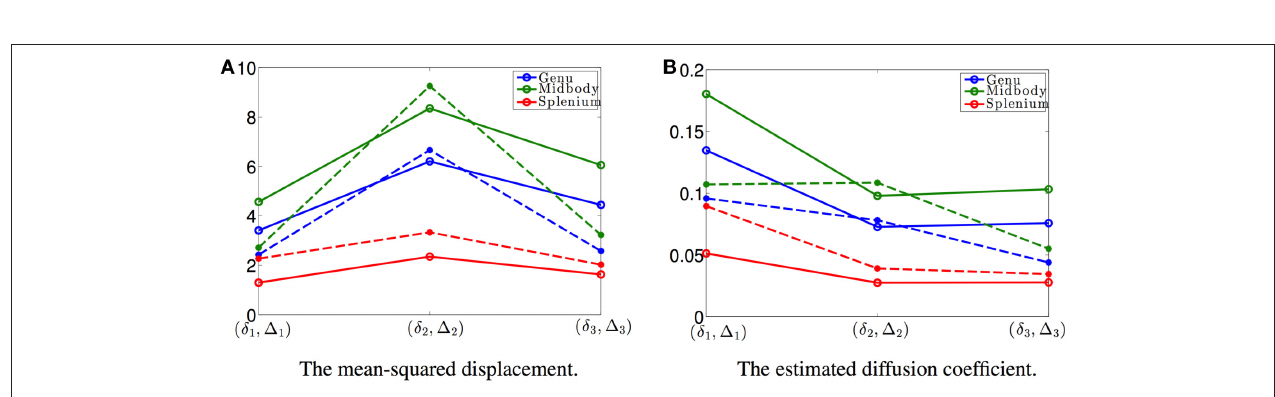
FIGURE 3 | (A) shows the mean-squared displacements of the three data sets with different ( δ,1 ) with the values shown in Figure 2F : the solid curves are the estimated results using the proposed model and the dashed lines are the corresponding results obtained from the DTI model, respectively. (B) shows the corresponding time-dependent diffusion coefficients for the three data